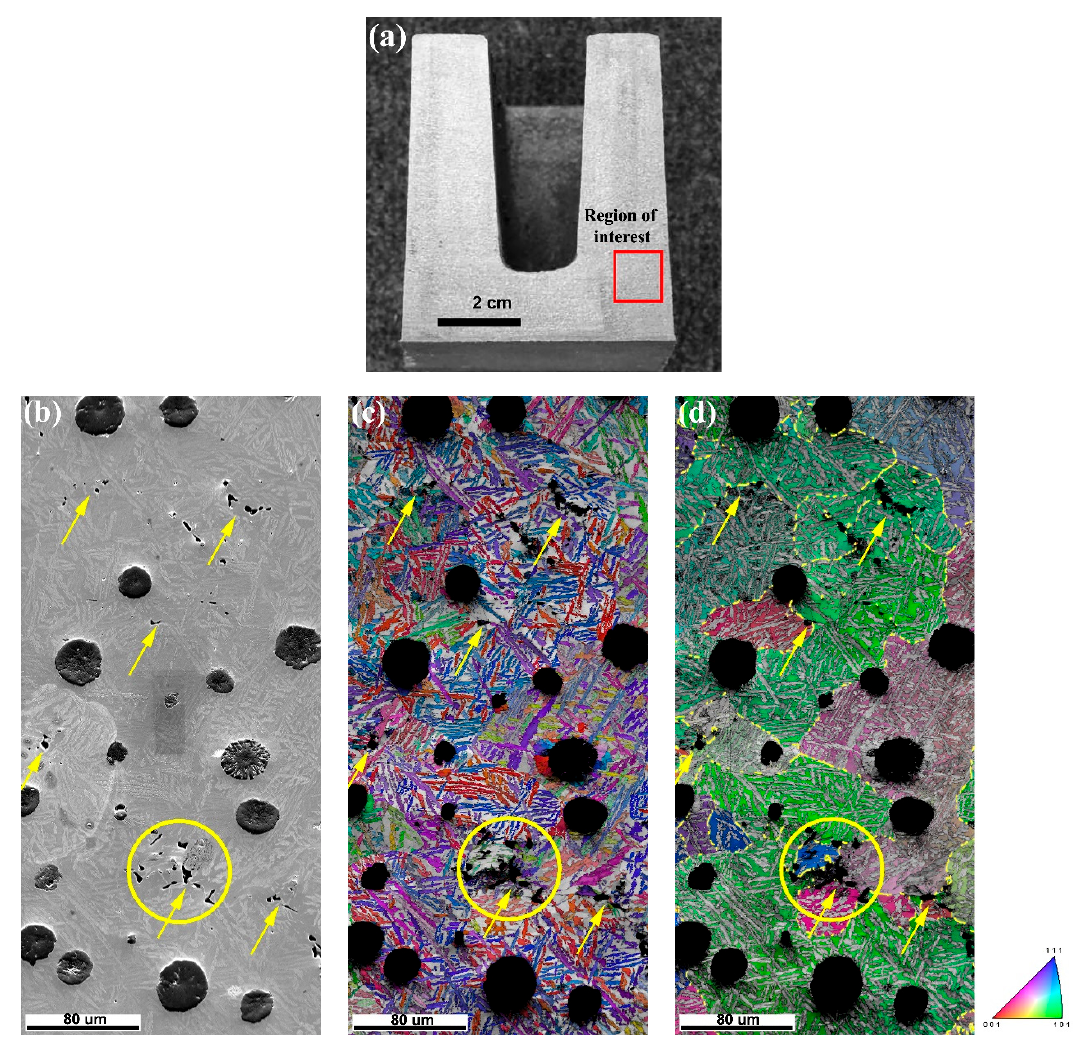
Figure 2. ( a ) Middle cross section of the “bathtub” component; ( b ) SEM image of the region of interest (ROI); IPF map of ( c ) ferrite and ( d ) austenite phases, over-imposed to the image quality (IQ) map. Austenite high angle grain boundaries (misorientation > 15°) are highlighted by yellow lines in ( d ). Arrows show the micro-shrinkage porosities and circle is highlighting the accumulation of microporosities at the junction of austenite grain boundaries.